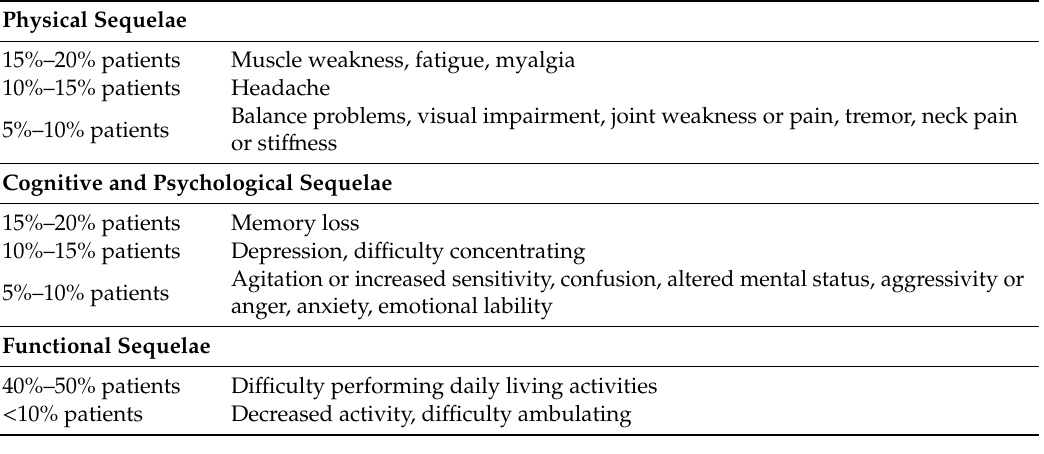
Table 1. Most widely reported West Nile virus (WNV)-related sequelae ( > 5%